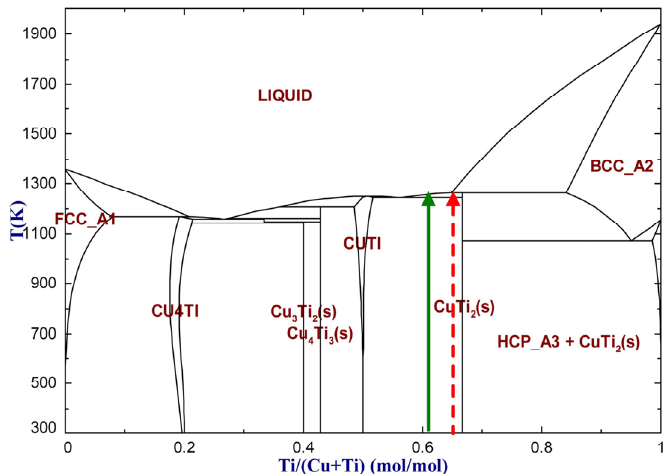
Figure 2. Binary phase diagram of Cu and Ti from FactSage 7.3 databases [33].